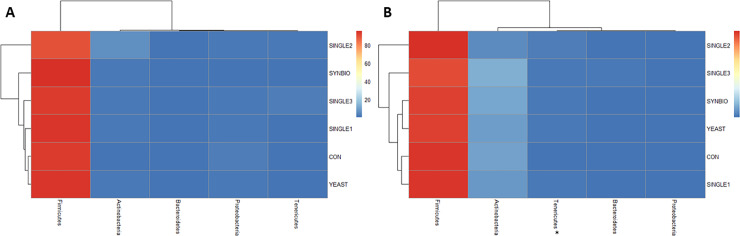
Cecal bacterial abundance at phylum-level of broilers fed different probiotics by 21 and 42 days of age.(A) Heatmap plot represents the composition of cecal microbiota from broilers fed basal diet without probiotics (CON), synbiotic (SYNBIO), yeast-based probiotic (YEAST), or single-strain formulations composed of Bacillus amyloliquefaciens (SINGLE1), B. subtilis (SINGLE2), and B. licheniformis (SINGLE3) by 21 and (B) 42 days of age. Hierarchical clustering in the rows is based on the composition similarity between treatments, while that in the columns is based on the microbial relative abundance's closeness. Statistical differences (p<0.05) between groups were reported for each bacterial population (*).